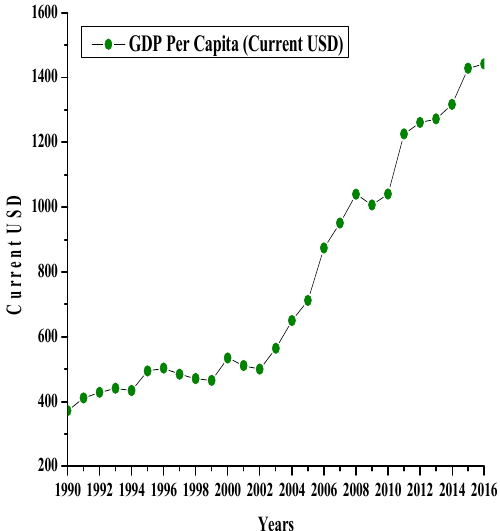
Figure 8. Gross Domestic Product (GDP) Per Capita in Pakistan.